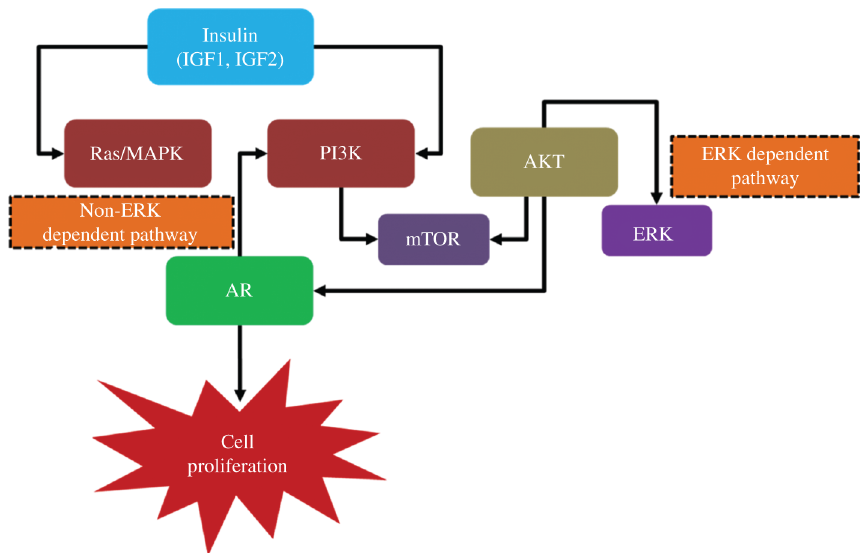
Figure 1: The interplay between AR, mTOR and MAPK signaling pathways.